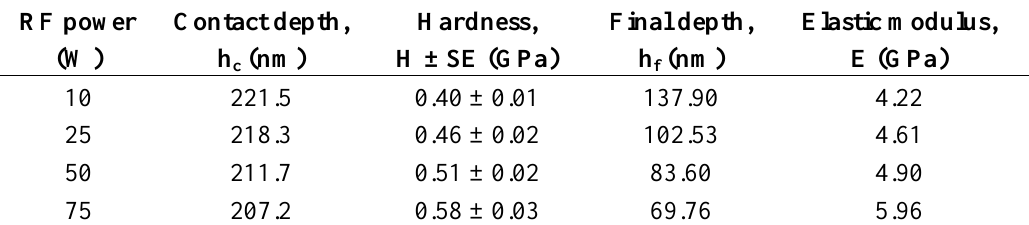
Table 4. Hardness parameters of pp–GT thin